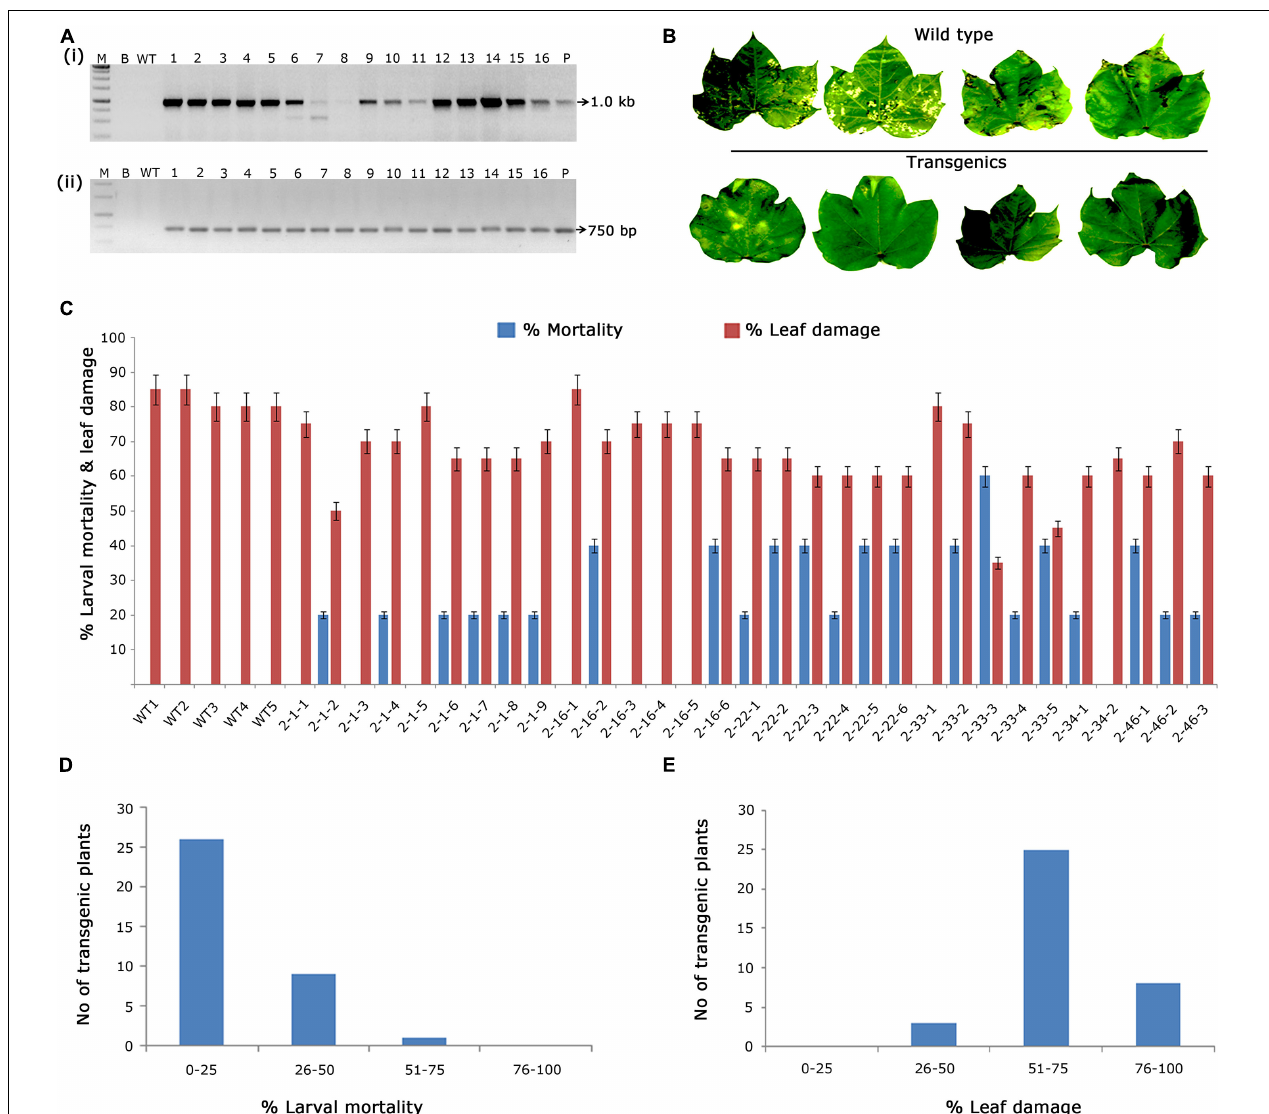
FIGURE 3 | Molecular analysis of cry2Aa cotton transformants in T 1 generation. (A) PCR analysis of T 1 generation cry2Aa plants for the amplification of (i) 1.0 Kb cry2Aa gene; (ii) 750 bp nptII gene. Lane M – 1 Kb Ladder (Thermo Scientific), Lane B – water blank (all PCR components without template DNA), Lane WT – wild type (100 ng), and Lanes 1–16: T 1 generation transgenic plant DNA 100 ng. Lane P – positive control pBinAR cry2Aa (25 ng). (B) Representative leaves of wild type and transgenic plants challenged in insect leaf bioassay. (C) Graphical representation of the performance of 30 transgenic plants and wild type in terms of percentage of larval mortality and leaf damage. (D,E) Overview of the efficacy of transgenic plants against deliberate challenging of Helicoverpa armigera larvae.